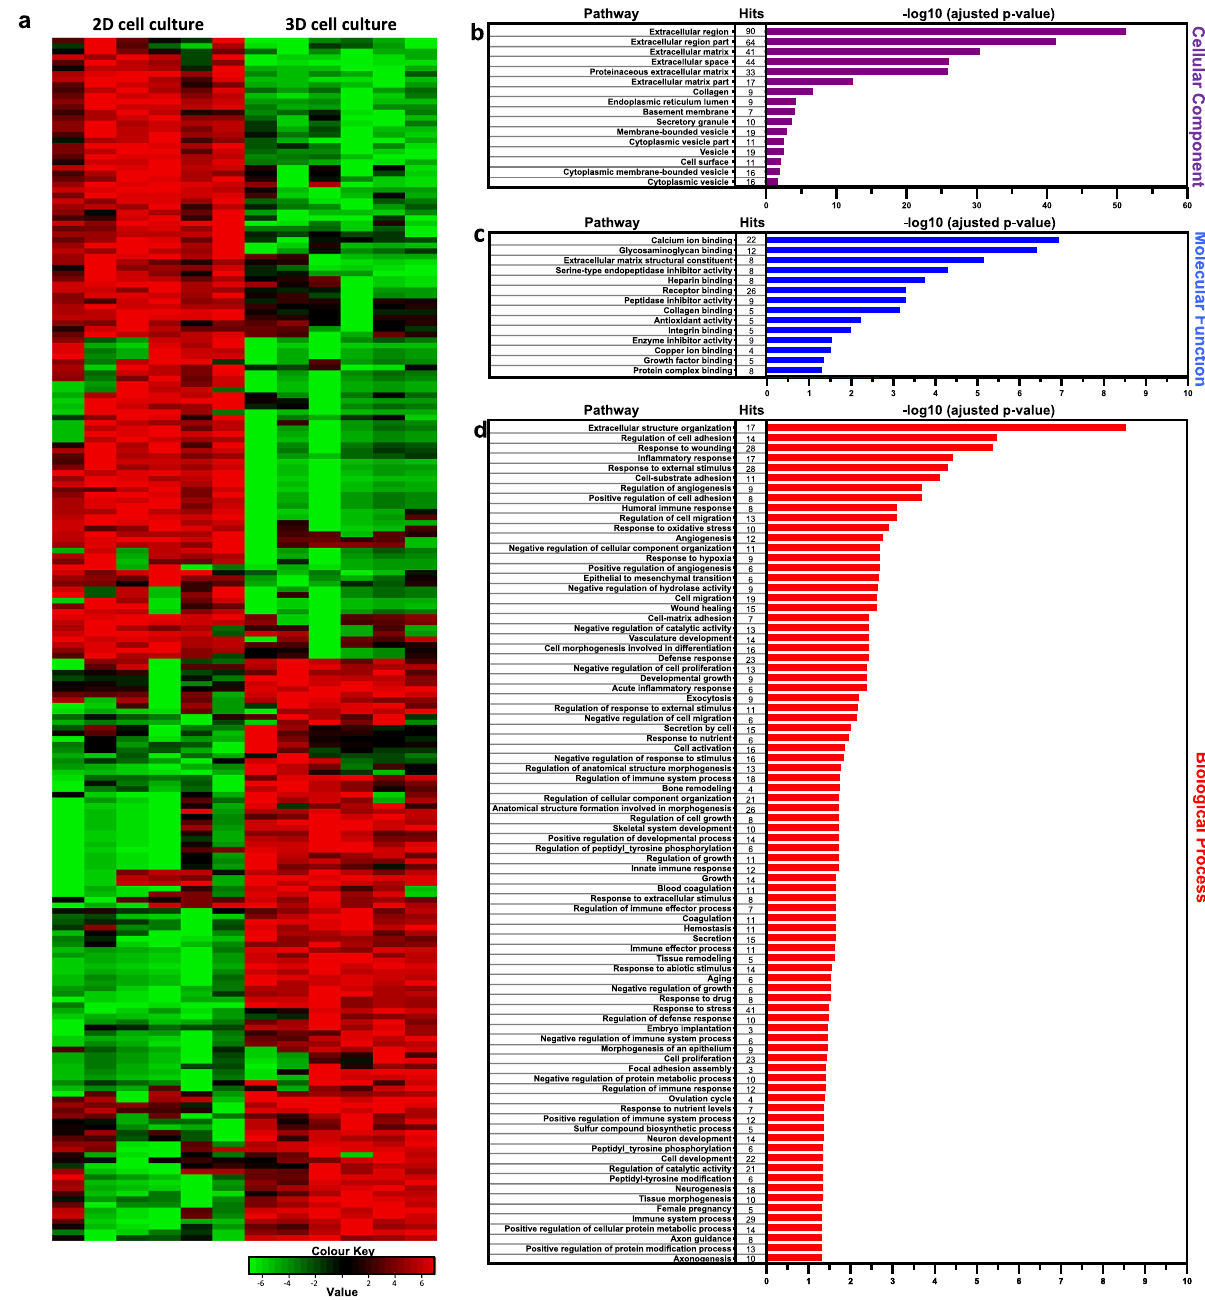
Figure 3. Proteomic and Gene Ontology enrichment analysis of exosomal protein isolated from dermal fibroblasts. ( a ) Heat map showing significantly deregulated proteins depending on the culture method. ( b – d ) Gene ontology enrichment analysis of differentially overexpressed exosomal proteins isolated from conditioned media of 3D dermal fibroblasts cultures. GO cellular component ( b ), molecular function ( c ) and biological process ( d ) enrichment analyses were performed using Network Analyst. Significantly enriched GO terms are shown with Benjamini–Hochberg FDR-corrected p-values and the number of hits is also included for each